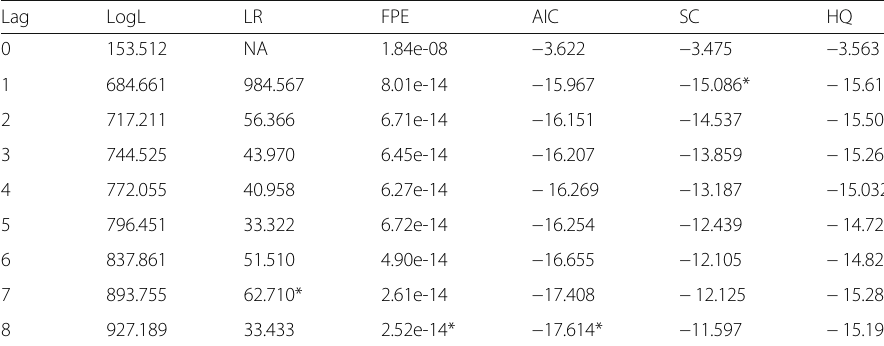
Table 7 Lag-order selection criteria